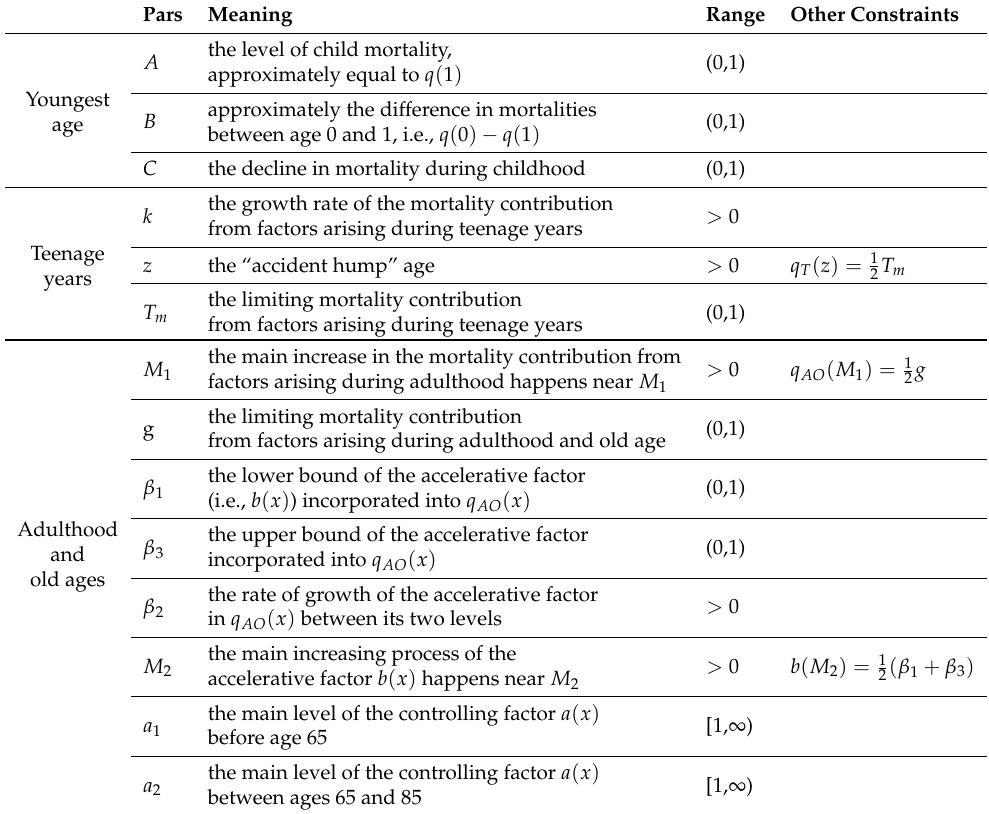
Table 9. Parameters in